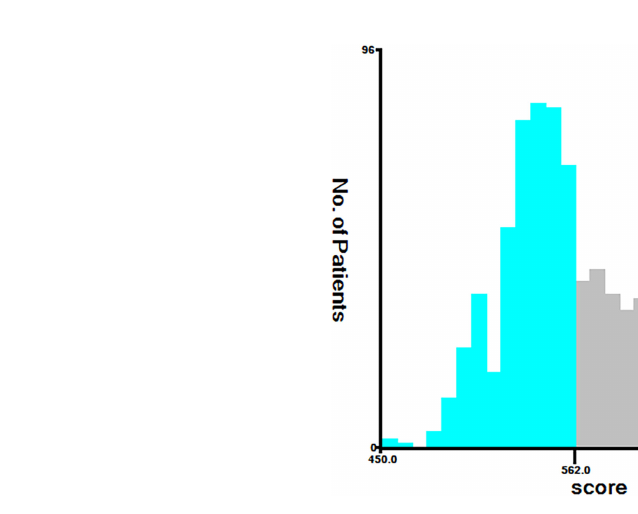
FIGURE 7 Cut-off point for risk strati fi cation selected using